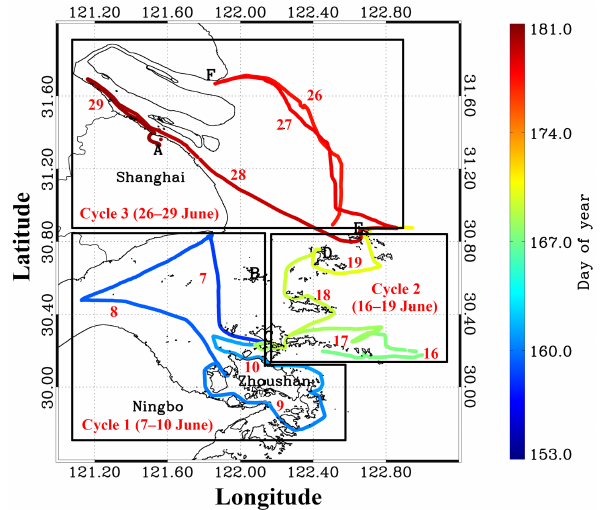
Figure 11. Three typical observation periods in characteristic ob- servation